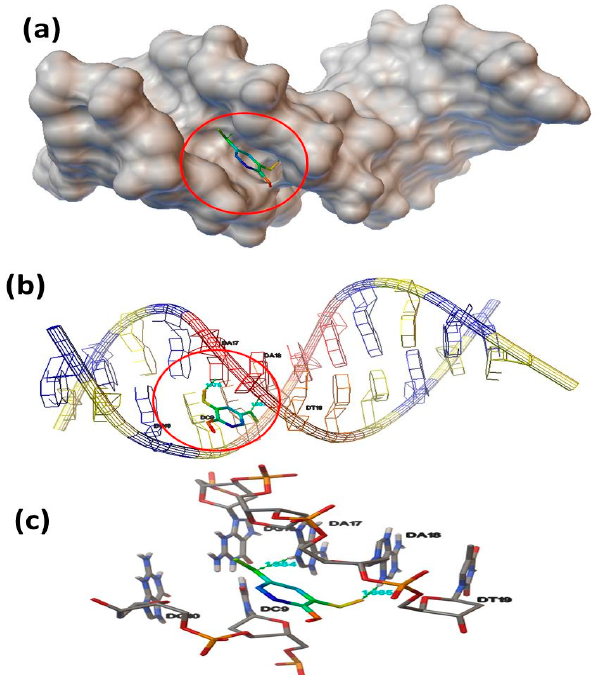
Figure 11. ( a ) Schematic representation of the binding position of the exo -isomer to DNA. ( b ) Interactions of the exo -isomer with the nuclides of the one DNA helix. ( c ) Hydrogen-bonding interactions of the exo -isomer with DNA adenosines (DA17: H ∙∙∙ OMe and DA18: H ∙∙∙ O=C). Molecules 2020 , 25 , x Similar to the exo -isomer, the endo -isomer was also in contact with DNA via a minor groove isomer developed two longer hydrogen-bonding interactions with the DNA adenosines, i.e., DA17:H ∙∙∙ OMe (ligand) with 2.481 Å and DNA DA18:H ∙∙∙ O=C (ligand) with 1.927 Å (Figure 12c).